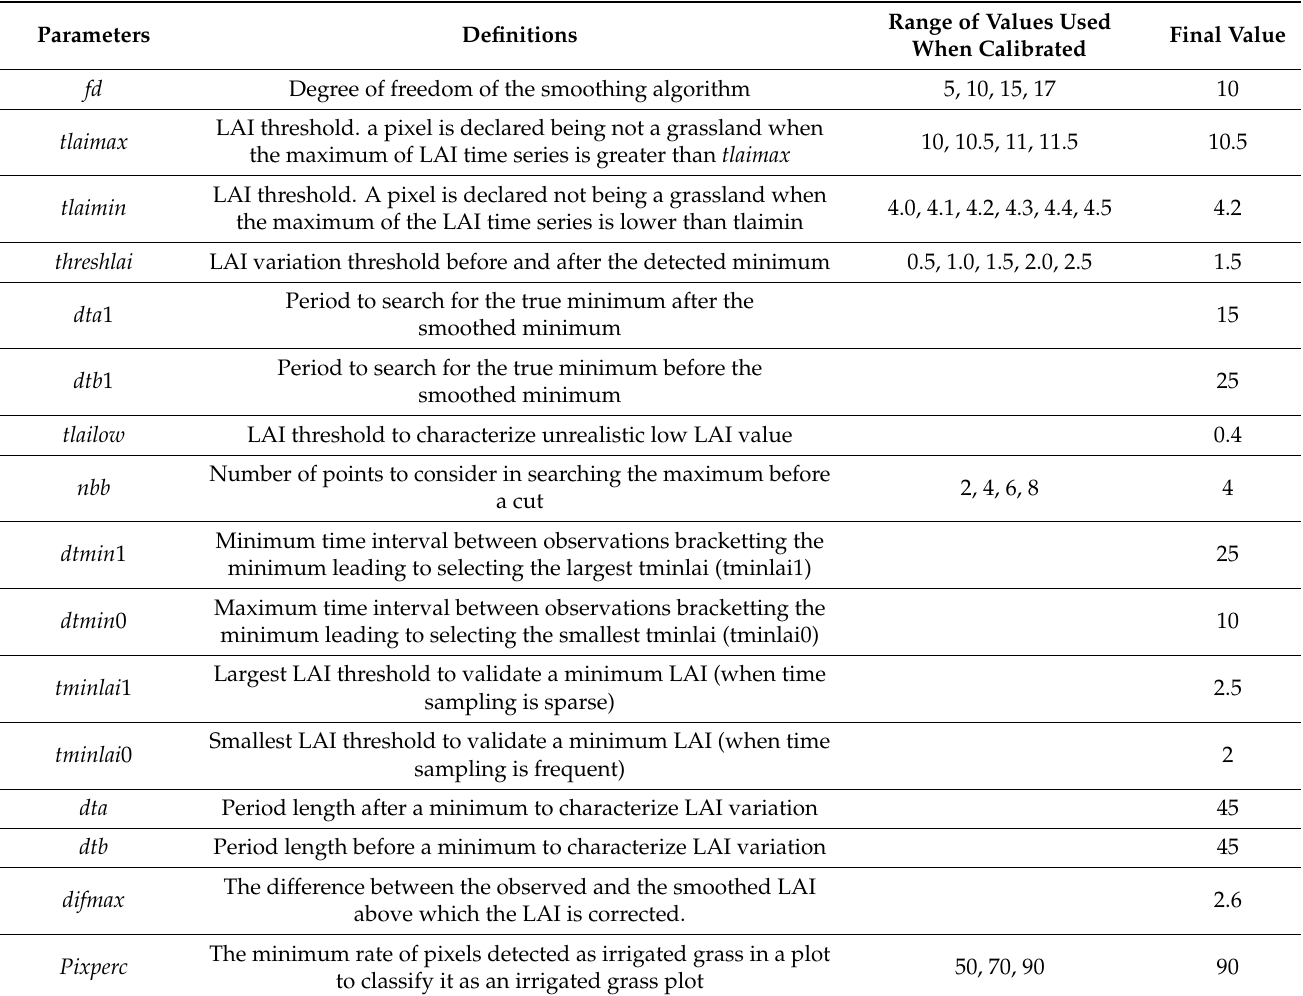
Table 2. List of parameters and value retained to implement the developed